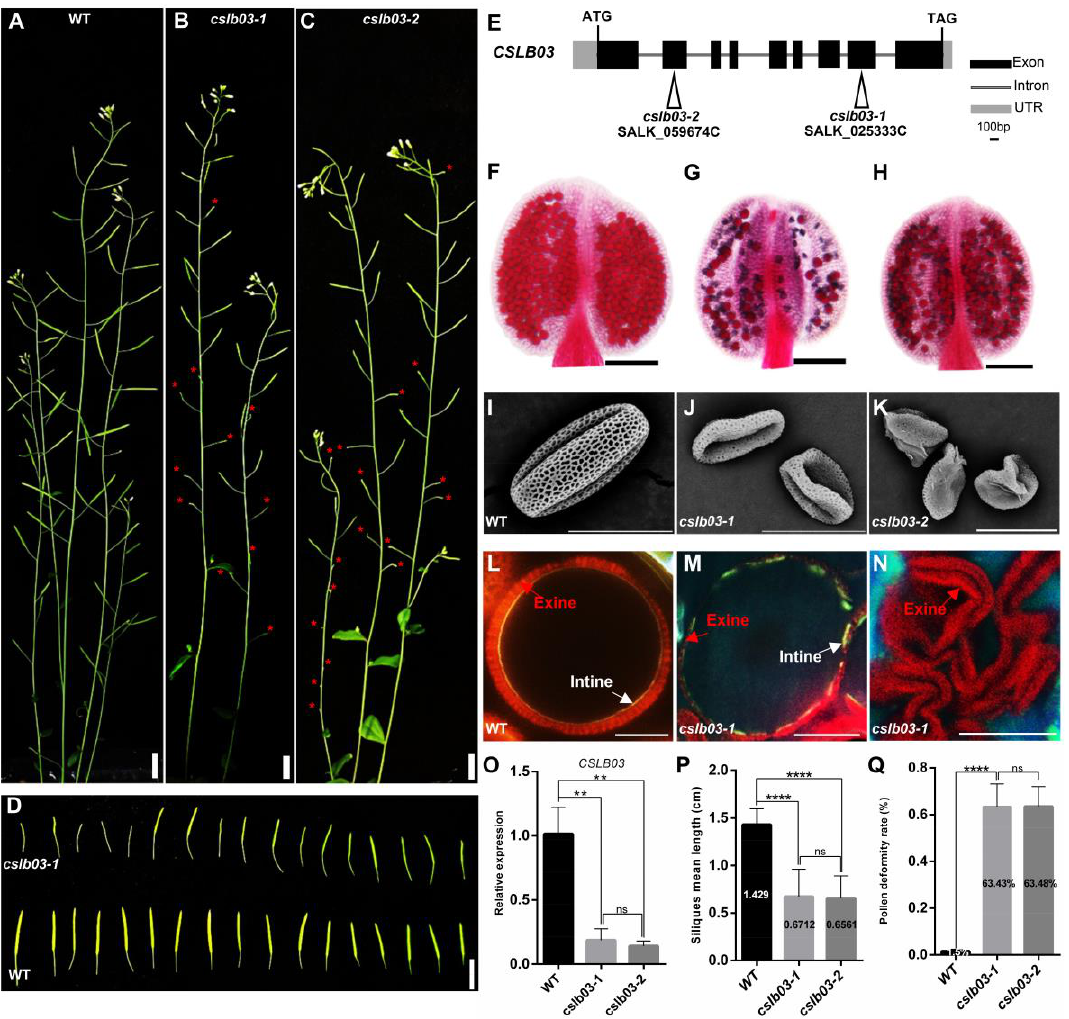
Figure 7. Pollen developmental phenotypes of cslb03 mutant plants. ( A – C ) Plant fertility of the WT ( A ), cslb03-1 ( B ), and cslb03-2 ( C ) plants. Red asterisks indicate severely aborted siliques. Bar = 1 cm. ( D ) Silique phenotypes of the WT and cslb03-1 mutant plants. Bar = 1 cm. ( E ) Schematic diagram of the T-DNA insertion sites of the cslb03-1 and cslb03-2 mutants. ( F – H ) Alexander staining of anthers of the WT ( F ), cslb03-1 ( G ), and cslb03-2 ( H ) plants. Bars =100 μm. ( I – K ) SEM image of the WT ( I ), cslb03-1 ( J ), and cslb03-2 ( K ) pollen grains. Bar = 20 μm. ( L – N ) Staining of the exine and intine structure of pollen grains from the WT ( L ) and cslb03-1 ( M , N ) plants. Bars =10 μm. ( O ) The relative expression levels of the CSLB03 gene in the WT, cslb03-1 , and cslb03-2 inflorescence. ( P ) The average length of siliques from the WT, cslb03-1 , and cslb03-2 mutant plants. ( Q ) The rate of defective pollen in the WT, cslb03-1 , and cslb03-2 anthers. Values of ( O ) are mean ± SD of three independent experiments. Values of ( P , Q ) are mean ± SD of more than three independent plants. The asterisks indicate a statistically significant difference (**, p < 0.01 ; ****, p < 0.0001, ns indicates no significant difference, Student’s t -test).